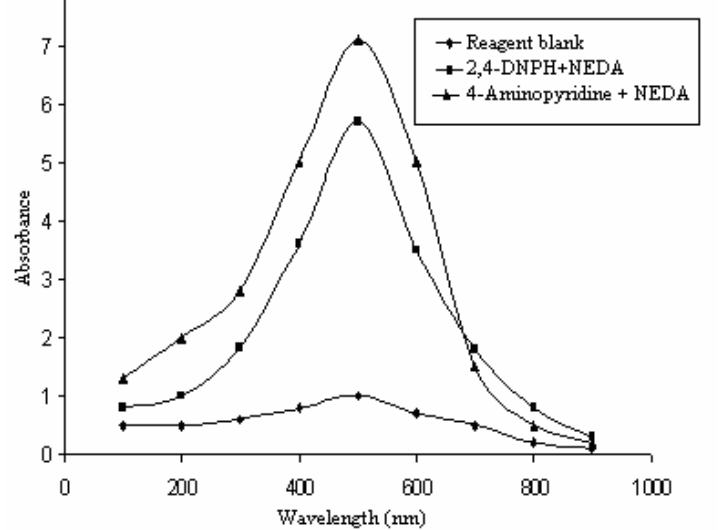
Figure 1 . Absorption spectra of oxidative coupling reaction of 2,4 DNPH+NEDA and 4- Aminopyridine +NEDA with vanadium